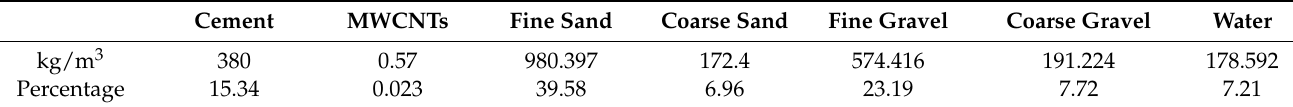
Figure 2. Different aggregate grading test results according to Standard ASTM C136/C136M-14 [44]. Table 2. Mix design.